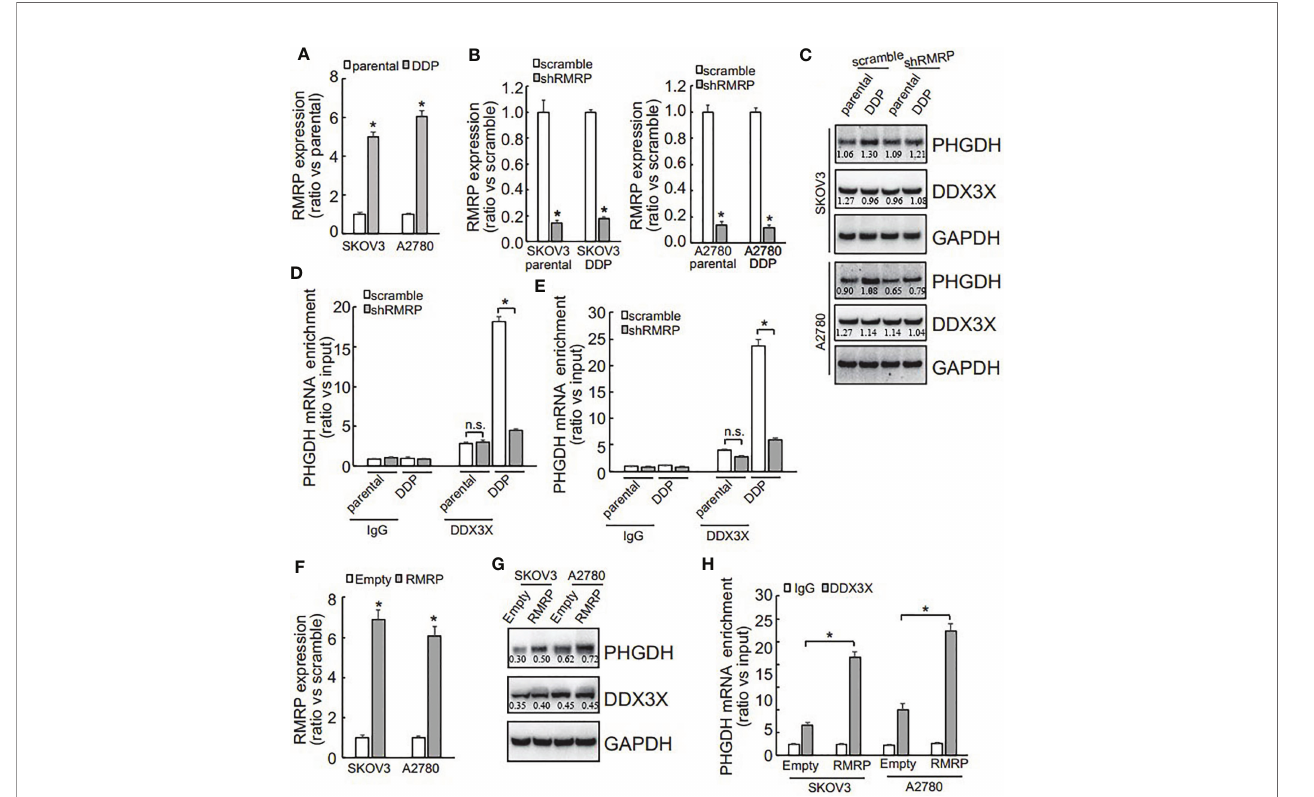
FIGURE 6 | RMRP is increased and promotes recruitment of DDX3X to PHGDH transcript in cisplatin-resistant ovarian cancer cells. (A) qRT-PCR was performed to analyze the RMRP expression. (B, C) cells were infected with scramble GV118 lentivirus vector (scramble) or shRNAs against RMRP (shRMRP), knockdown ef fi ciency was con fi rmed by qRT-PCR (B) , PHGDH expression was analyzed using Western blot (C) . (D, E) RIP was performed using IgG or DDX3X antibody from parental and DDP paired SKOV3 (D) and A2780 (E) infected with scramble or shRMRP. (F, H) cisplatin-sensitive SKOV3 and A2780 cells were infected with empty pGCLV-GV166 lentivirus vector (empty) or lentivirus containing RMRP (RMRP), or RMRP, expression of RMRP was analyzed using qRT-PCR (F) , PHGDH expression was investigated using Western blot (G) , recruitment of DDX3X on PHGDH transcript was studied using RIP (H) . * P < 0.05, n.s., not signi fi